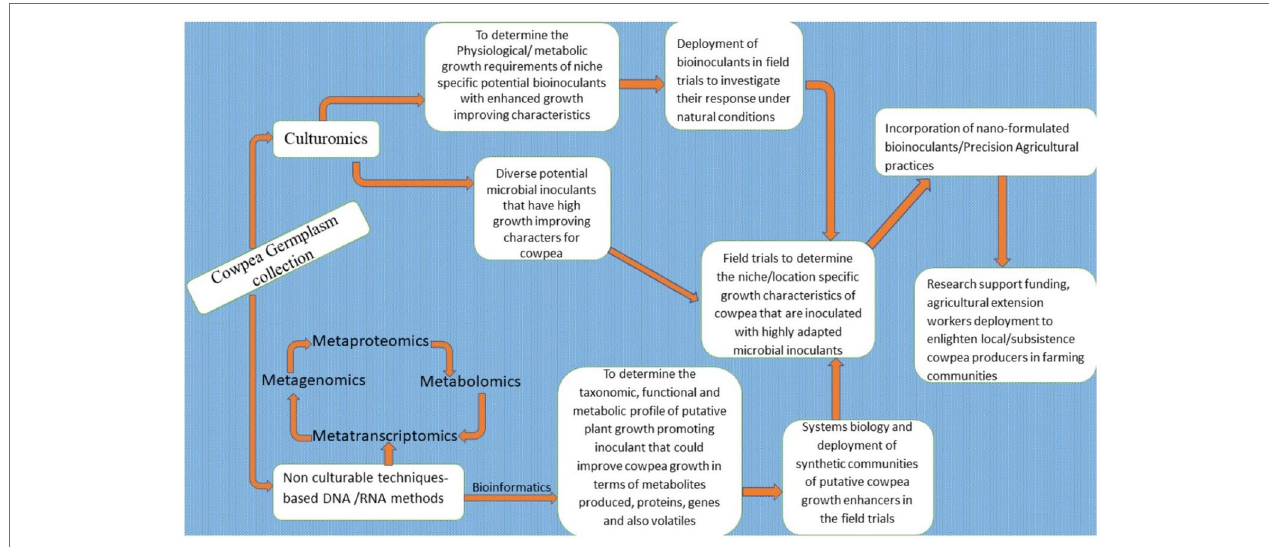
FIGURE 4 | Holistic approach and futuristic perspectives for improving cowpea productivity enhancement in Africa and consolidating the continent’s foremost producer